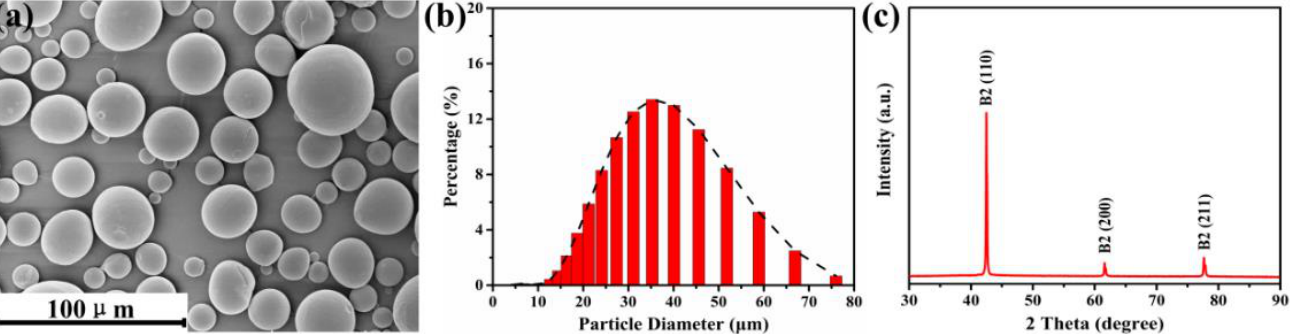
Figure 4. The as–received NiTi powders: ( a ) Powder morphology; ( b ) particle size distribution [24]; ( c ) XRD patterns.